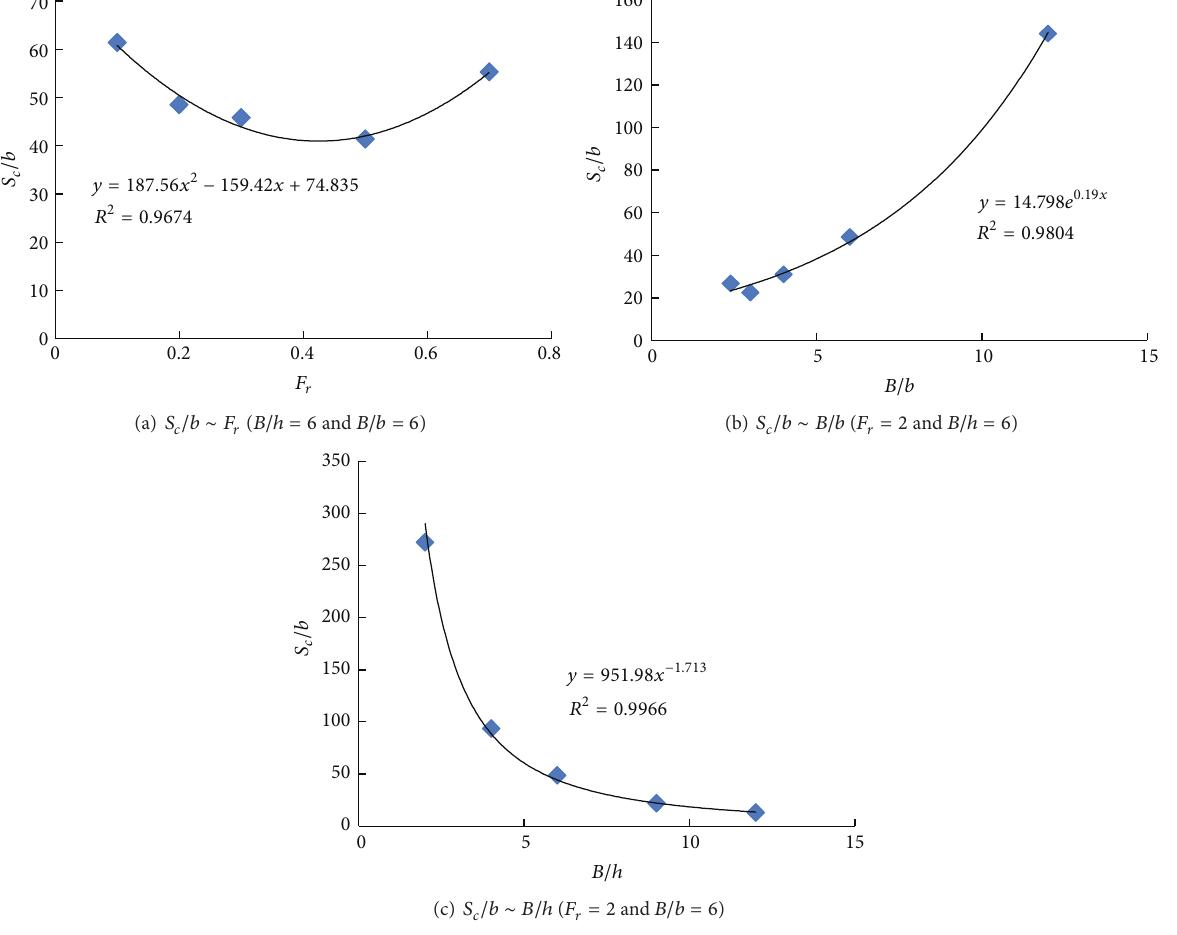
Figure 4: Variation of 𝑆 𝑐 /𝑏 with 𝐹 𝑟 , 𝐵/𝑏 and 𝐵/ℎ .